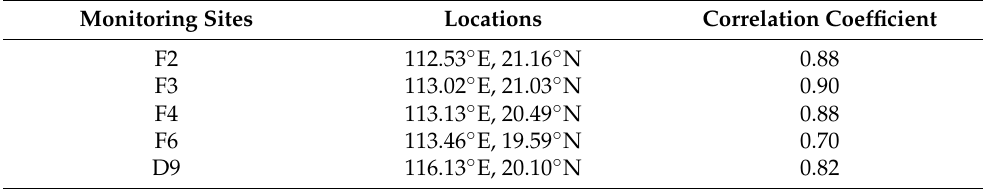
Table 4. Correlation coefficient between vertical concentration profile and extinction coefficient profile at monitoring sites F2, F3, F4, F6, and